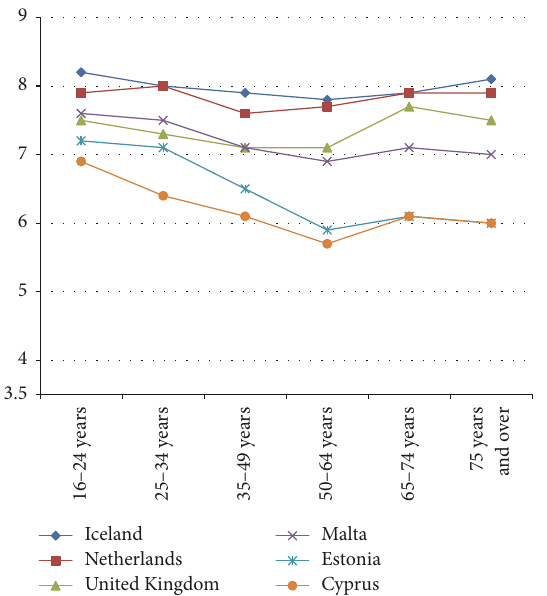
Figure 3: Relatively small U-shape in life satisfaction by age 2013.